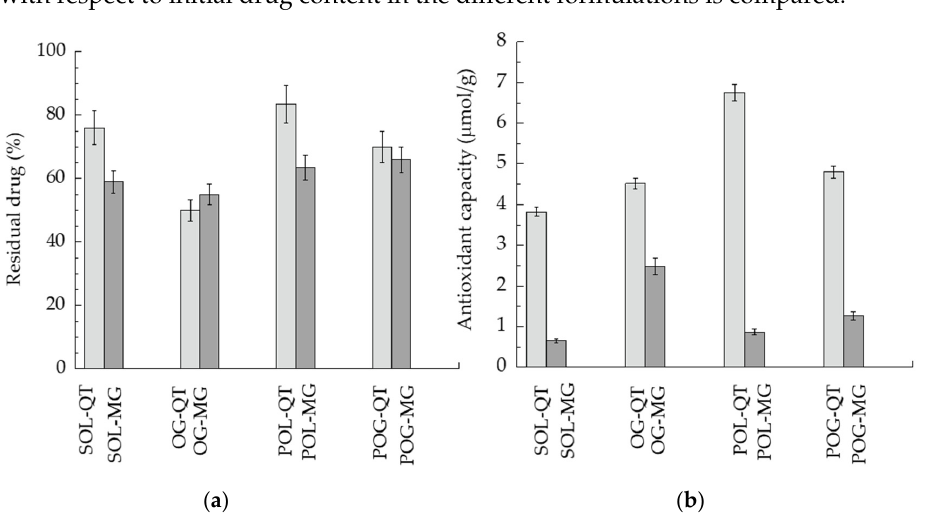
Figure 5 . ( a ) QT (light gray) and MG (gray) content in formulations stored for 120 days at 25 °C, expressed as percentage with respect to the initial drug content. ( b ) Antioxidant capacity of QT (light gray) and MG (gray), as detected by ACL test, referring to μ mol TE/g of sample. In general, MG was more prone to degradation with respect to QT, as indicated by residual drug content in the case of the drugs in solution. Notably, POL-QT was able to improve QT stability with respect to SOL-QT, maintaining 84% of drug content after 120 days. POL and POG better control MG stability with respect to SOL-MG, in agreement with diffusion kinetics. Conversely, OG was not suitable to control the degradation of both polyphenols. Notably, the obtained chromatograms were free of degradation products of QT and MG